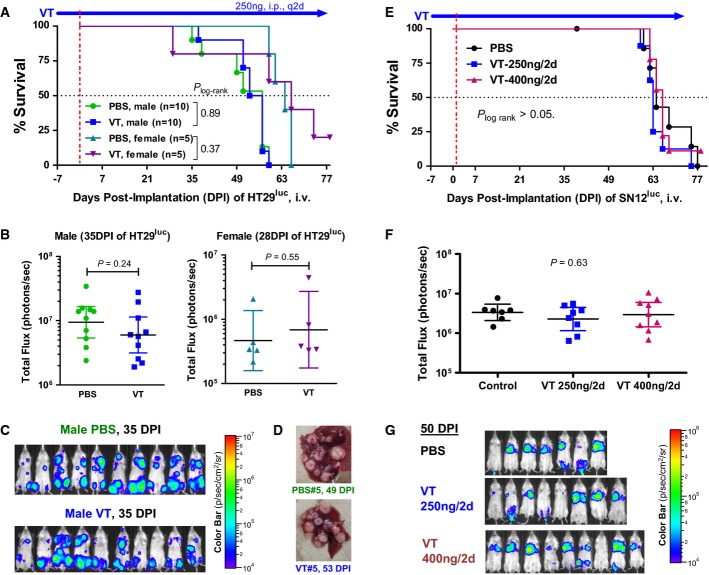
Vasculotide has no effect on experimental liver metastases from a colon cancer cell line (HT29luc), nor on experimental lung metastases from a renal cancer cell line (SN12luc)

A–D An experiment where HT29luc tumor cells were implanted intravenously into YFP-SCID mice. (A) Kaplan–Meier survival analysis. (B) Quantification of total metastatic burden in the liver and lymphatics, at 35 days post-implantation (DPI), from whole-body bioluminescent imaging (C). (D) Photograph of typical liver metastases.

E–G An experiment where SN12luc tumor cells were implanted intravenously into YFP-SCID mice. (E) Kaplan–Meier survival analysis. (F) Quantification of total metastatic burden at 50DPI, mostly within the lungs, from whole-body bioluminescent imaging (G).

Data information: Geometric means ± 95%CI are depicted in B and F. P values were derived by t-tests (B) or one-way ANOVA (F).